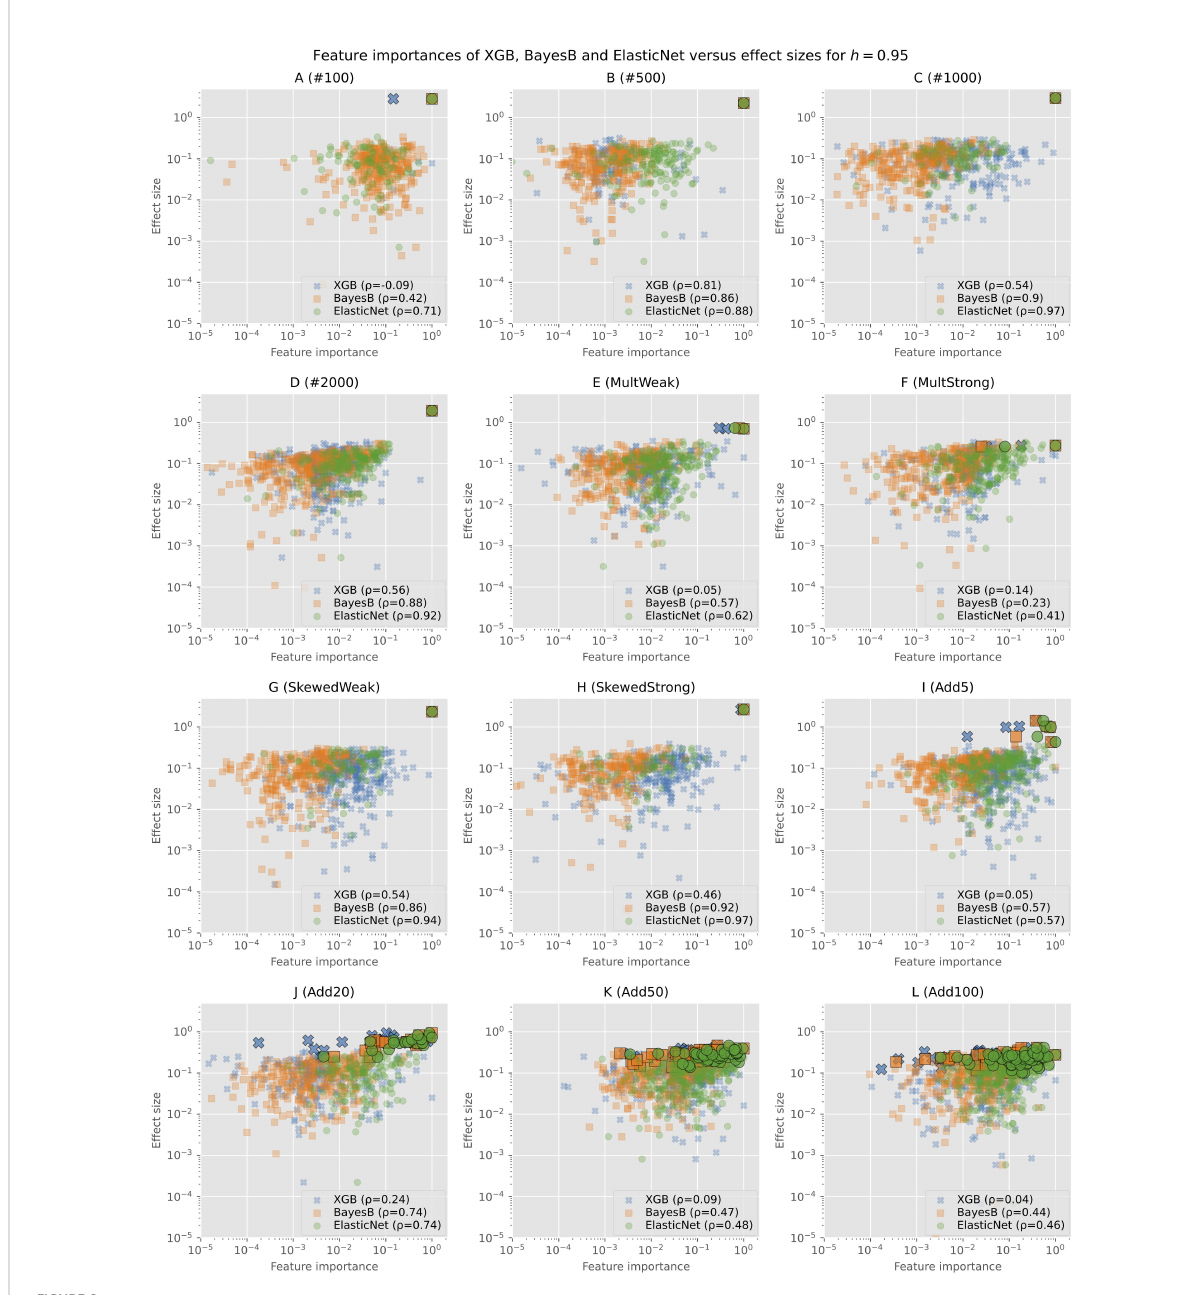
FIGURE 2 Min – max normalized feature importances of Bayes B, Elastic Net, and XGB in comparison with effect sizes on synthetic data for h =0.95: Each subplot shows the results of one of the simulation con fi gurations on a logarithmic scale. Only SNPs for which both the effect size and the feature importance are not zero are shown. Causal SNPs are highlighted by a larger marker size and a black frame. The legend additionally gives the Pearson correlation coef fi cient of the effect sizes and feature